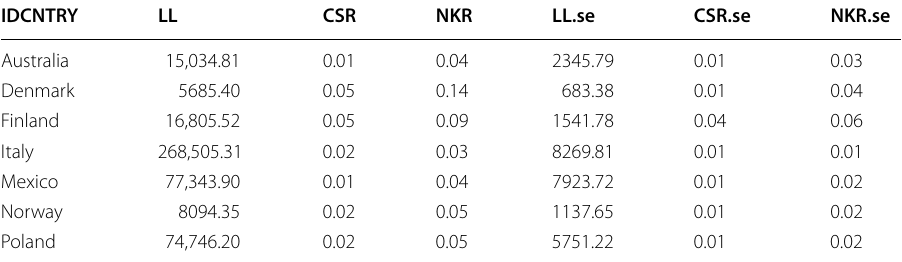
Table 14 Non participation in teachers’ professional development: results of the logistics regression models, models information, all countries including Italy, 2013 (Source: Author’s calculations based on OECD, TALIS